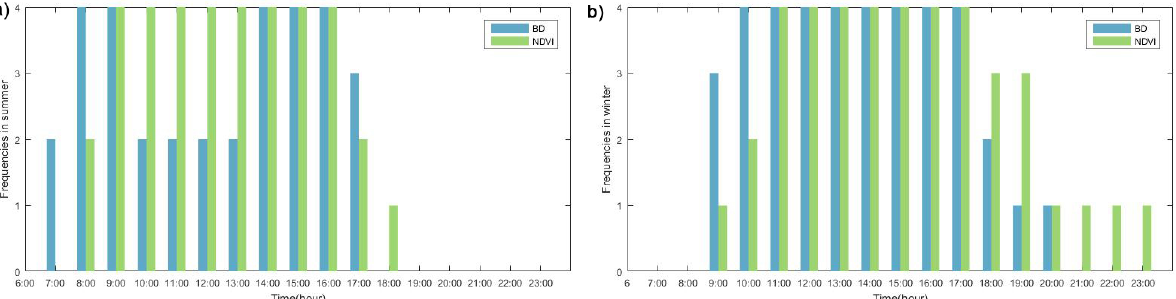
Fig 5. Frequencies of P-value>0.05 at each hour for summer (a)) and winter (b)).